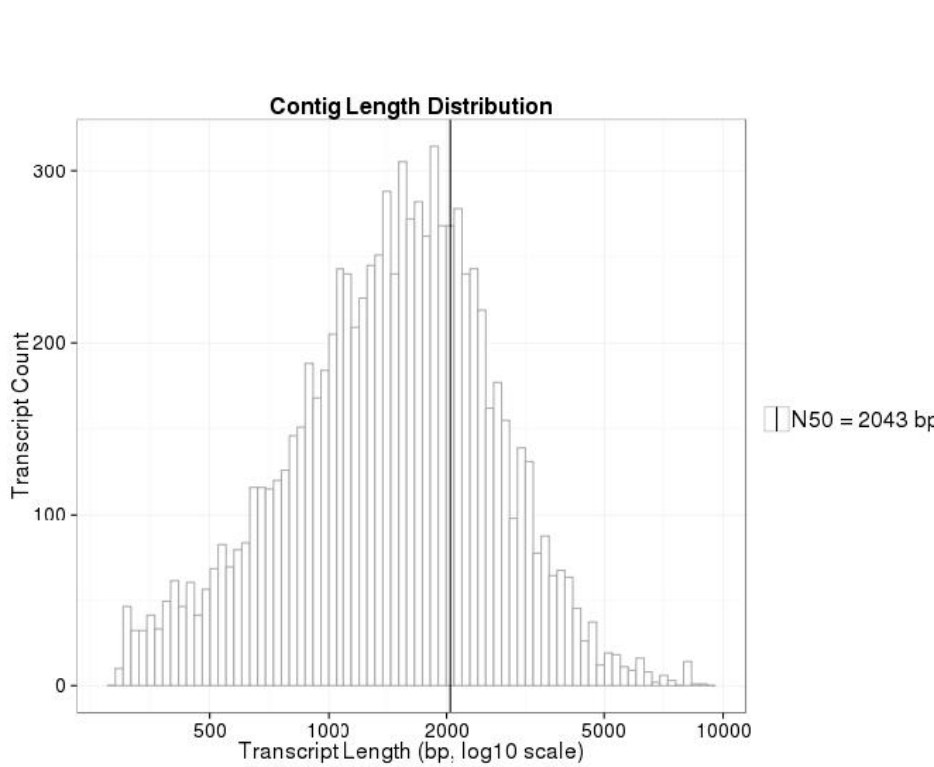
Figure A2. Transcript length distribution. The top graph shows the transcript length distribution after Trinity de novo assembly of the N. papyraceus stage 1 bulb transcriptome. The bottom graph shows the transcript length distribution after the BLAST annotation and filtered annotated components.